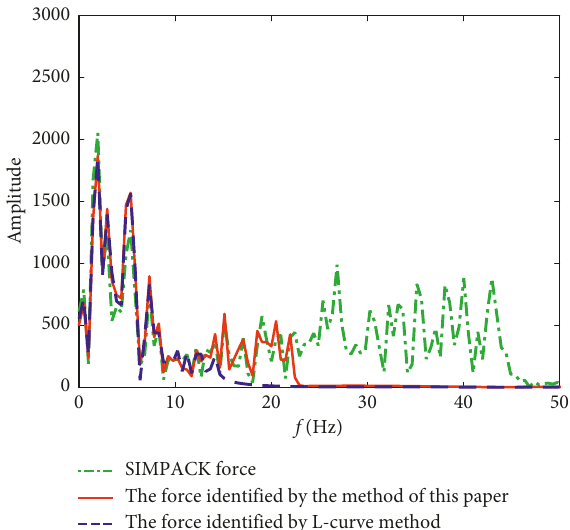
Figure 28: Amplitude-frequency curve of the two methods for F identification when the noise level is 4